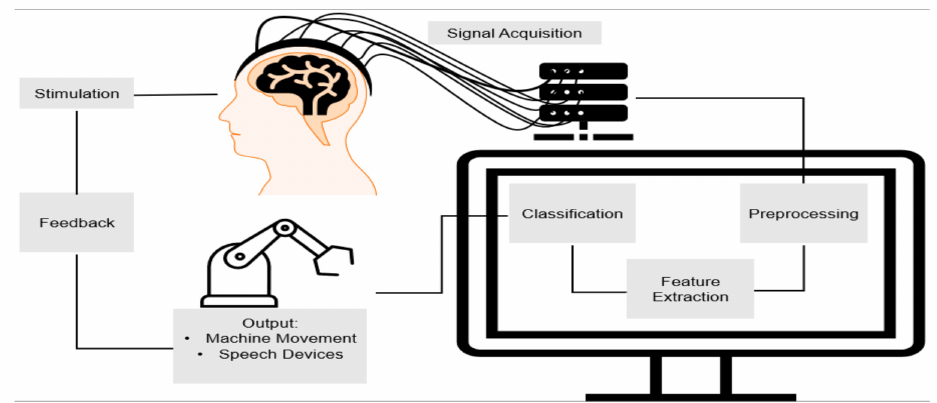
Figure 2. The process of brain–computer interfaces. The cycle begins with a stimulation that triggers brain activity. The activity is acquired in a variety of ways and sent to a computer for pre-processing. After processing the data, certain features are extracted, classified, and an output is determined and sent. The cycle begins anew after the output creates feedback of a new